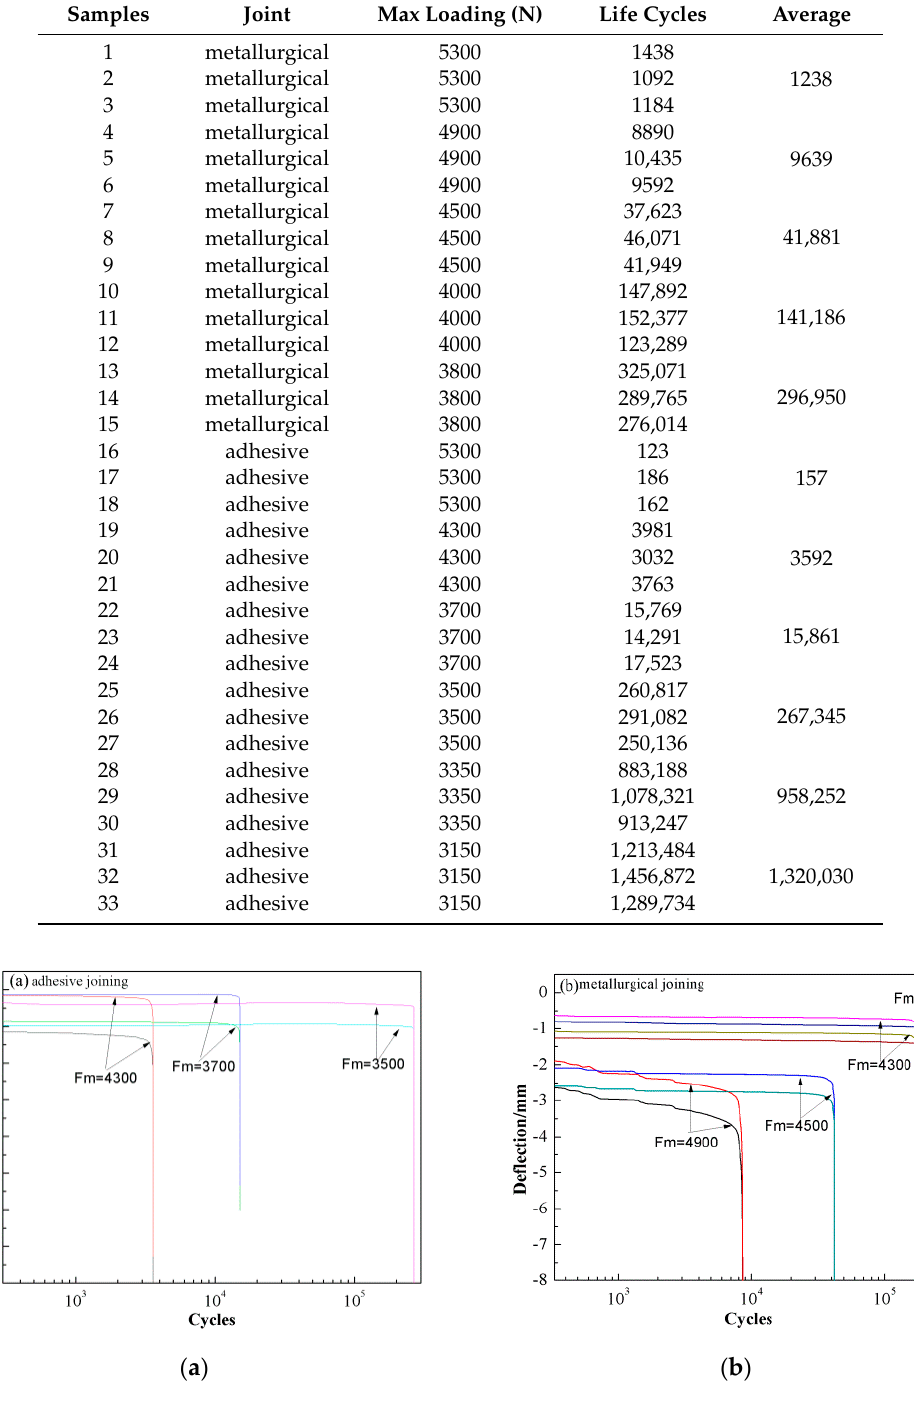
Figure 8. Deflection versus number of cycles of two kinds of samples ( a ) adhesive joining samples ( b ) metallurgical joining samples.